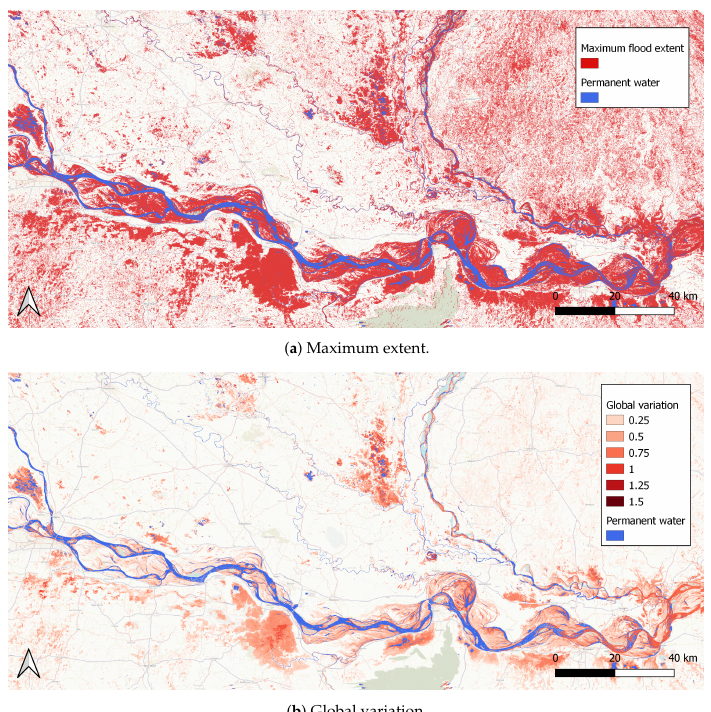
( b ) Global variation. Figure 5. Comparison between maximum flood extent map and global variation map for the India flood.